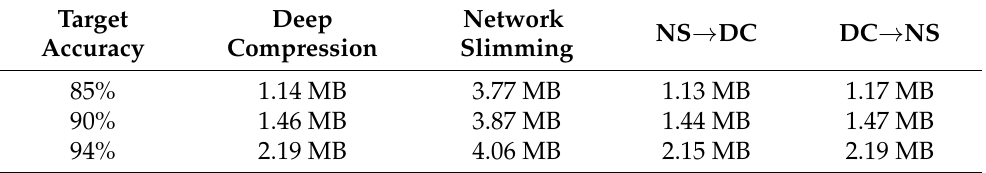
DC and DC NS for → →